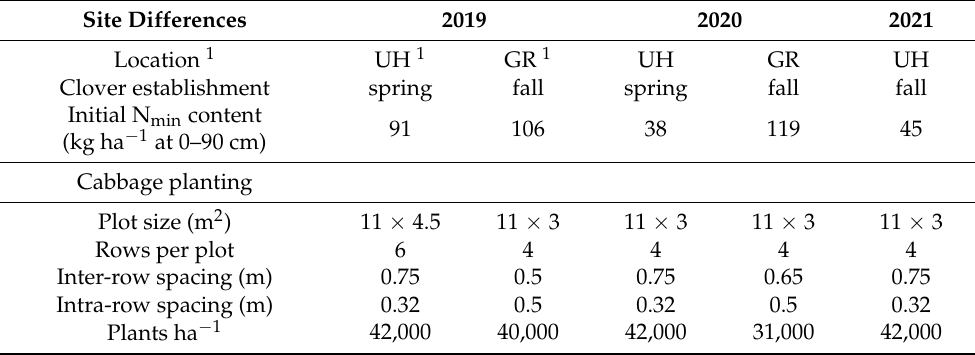
Table 2. Overview of differences in clover establishment, initial mineral nitrogen (N min ) content, plot size and spacing of cabbage planting in the trials in both locations and for three